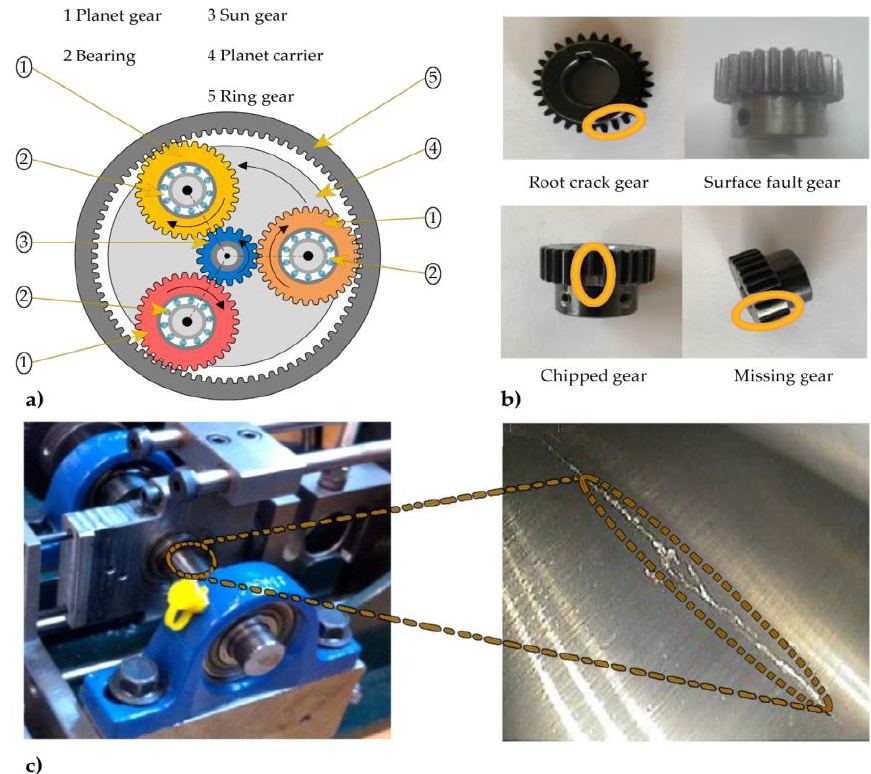
Figure 5. Gearbox components and fault types. ( a ) Components and rotation mechanism of gears of the planetary gearbox. ( b ) Gearbox gears failure types. Reproduced from [84], Elsevier and from [103], IEEE. ( c ) Internal race faults in high-speed shaft. Reproduced from [102], MDPI.